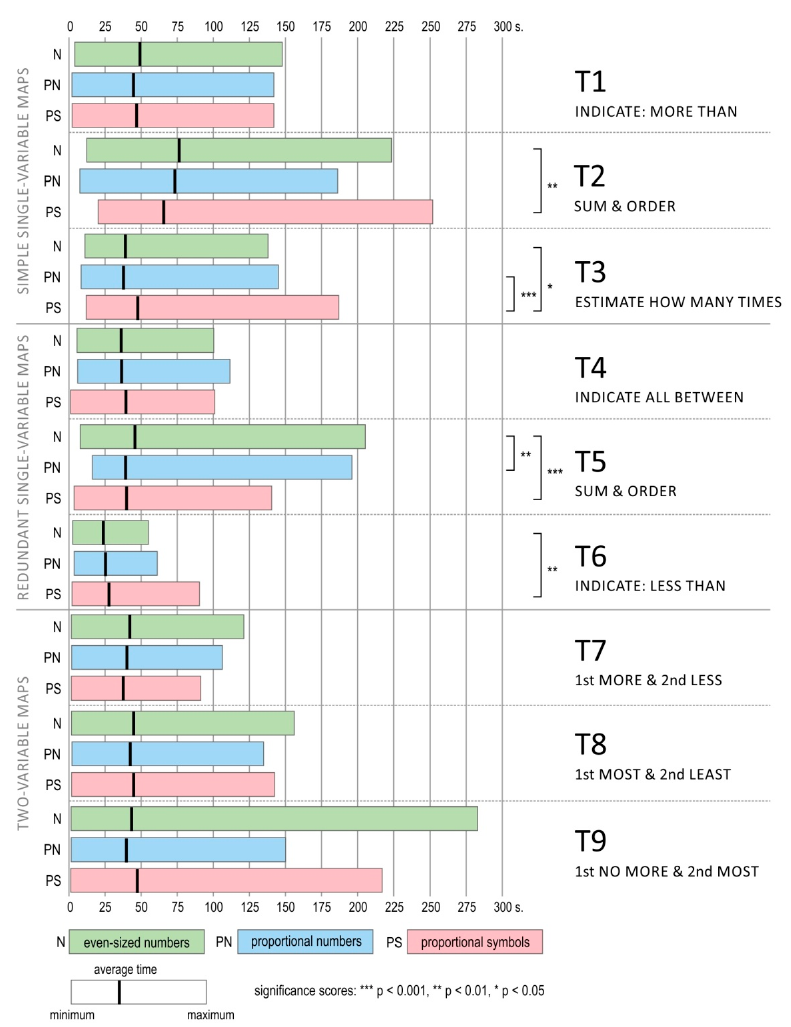
Figure 6. Minimal, mean (black line), and maximum time needed for users to solve tasks T1–T9.